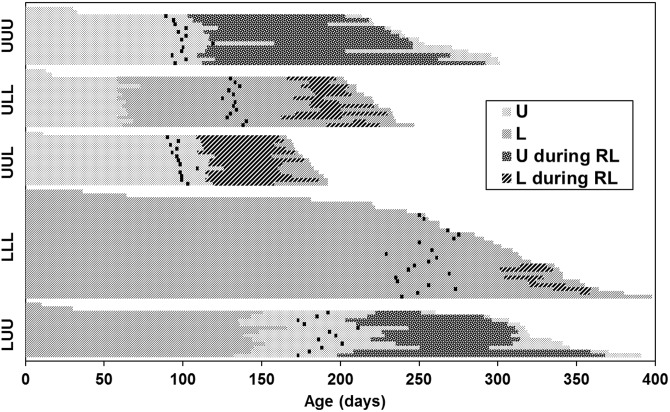
Event history diagram for individual insects maintained on five diet treatments.Each horizontal line represents the lifespan of one individual, with insects in each group arranged in order (top to bottom within a treatment group) from shortest to longest lifespan. U = unlimited access to food, L = limited access to food, RL = reproductive lifespan. The adult molt is indicated by a vertical black line. Data for insects that died during the juvenile stages are included in this diagram but were not included in any analyses except for survivorship curves (Fig. 5). Sample sizes: UUU n = 15, ULL n = 15, UUL n = 14, LLL n = 28, LUU n = 14.